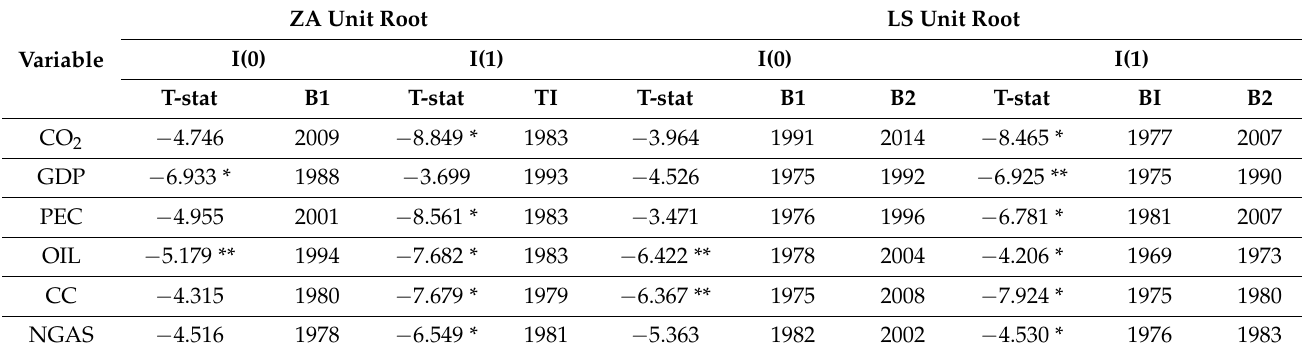
Table 4. Structural breaks unit roots outcome.